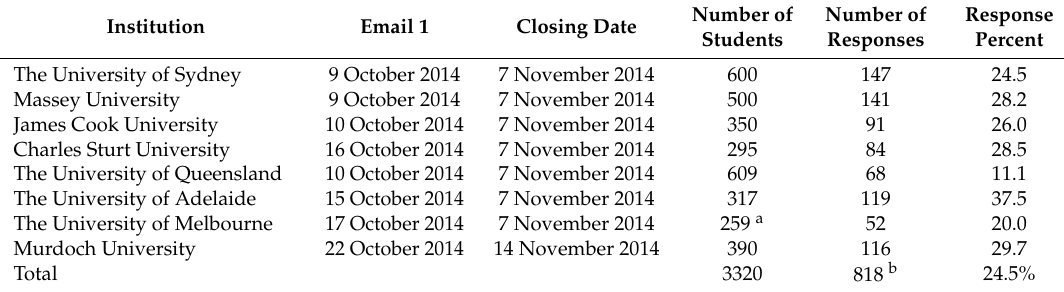
Table 1. Schedule for recruiting participants from institutions participating in this survey and response